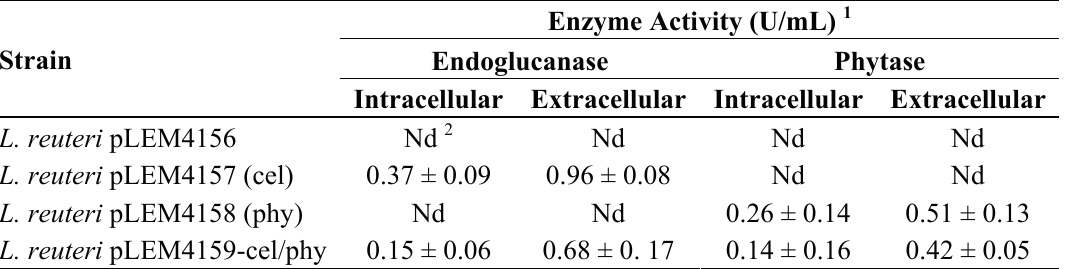
Table 1. Activity of endoglucanase and phytase of L. reuteri XC1